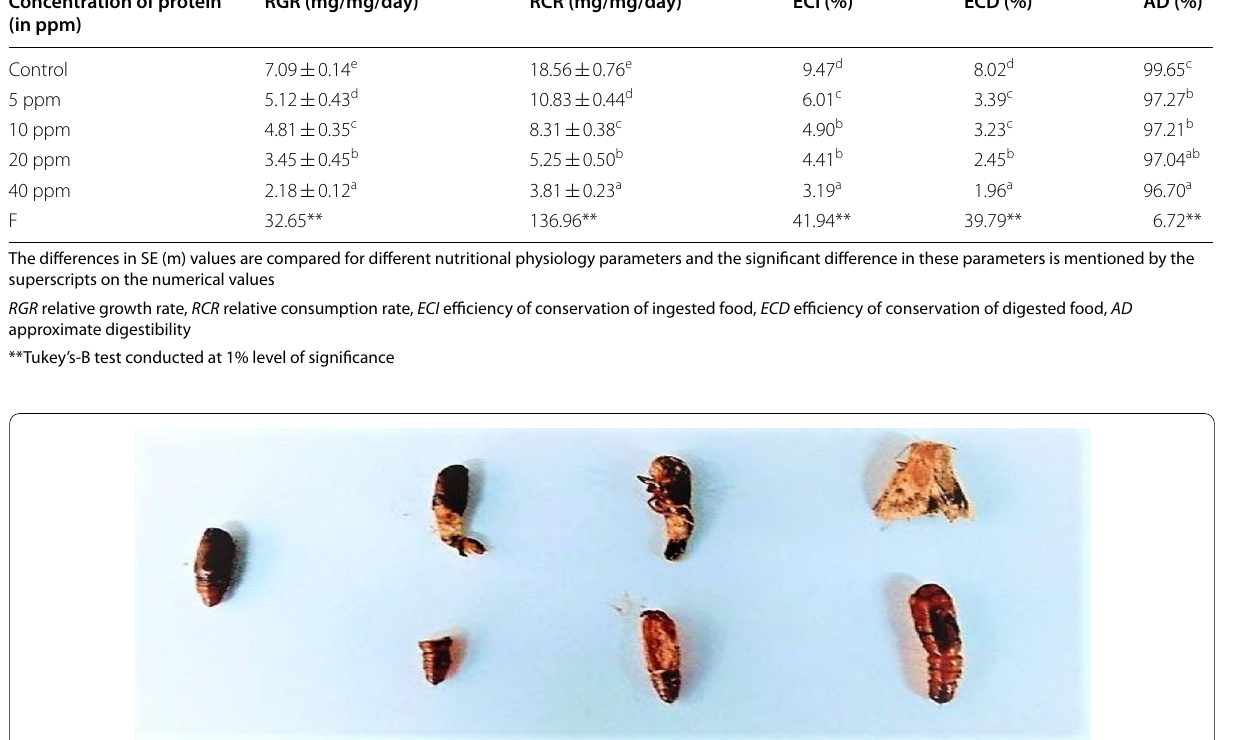
Fig. 5 Abnormal pupal moulting and formation of deformed adults in Helicoverpa armigera treated with 40 ppm protein concentration of Alternaria alternata